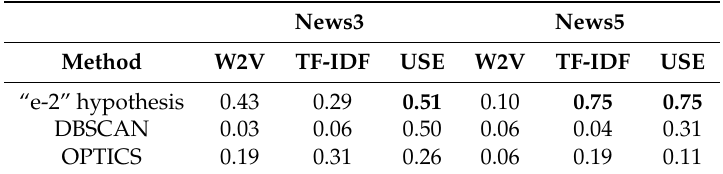
Table 5. NMI for News3 and News5.